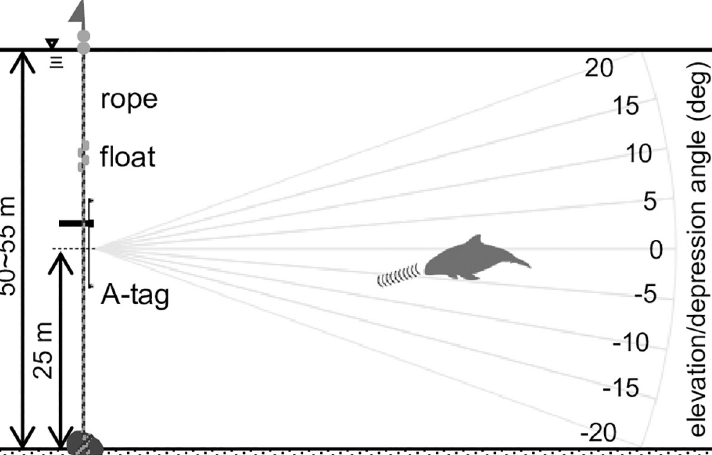
Fig 7. Diagram of the A-tag deployment and the relationship between recorded elevation/depression angle and the tag in the gillnet set-up off Rausu, Hokkaido, Japan. Numbers around the arc indicate elevation/depression angle